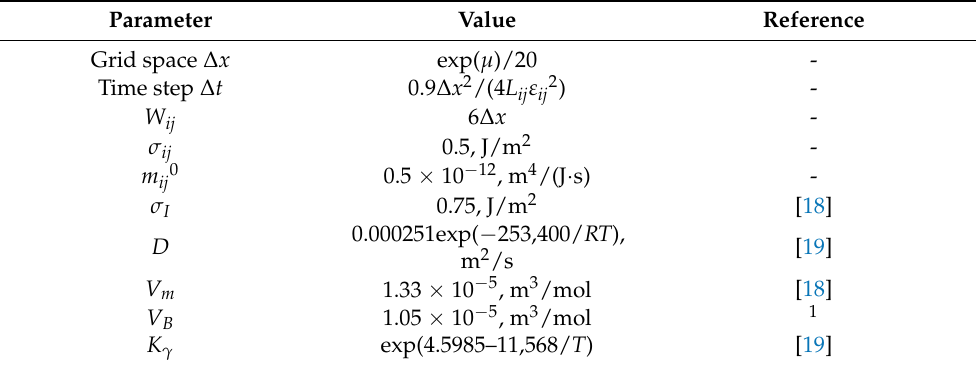
Table 2. Parameters in the multiple phase-field (MPH) simulation and Lifshitz − Slyosov − Wagner (LSW) calculation.